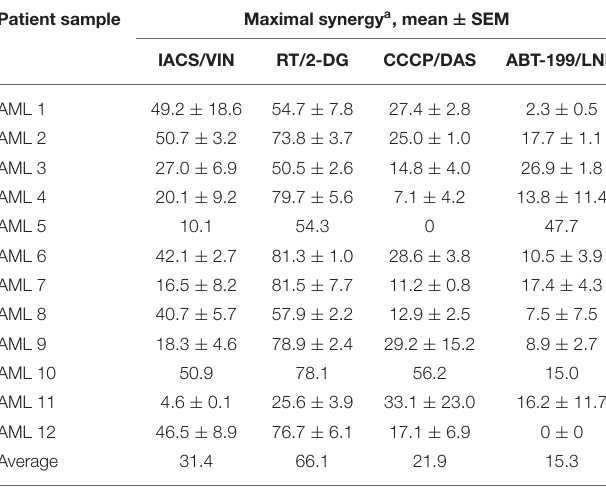
TABLE 4 | Effect of selected mitocan combinations on primary AML samples. Patient